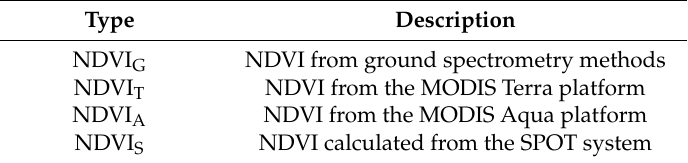
Table 2. Description of the versions of the NDVI derived from the different sensors used in this study.